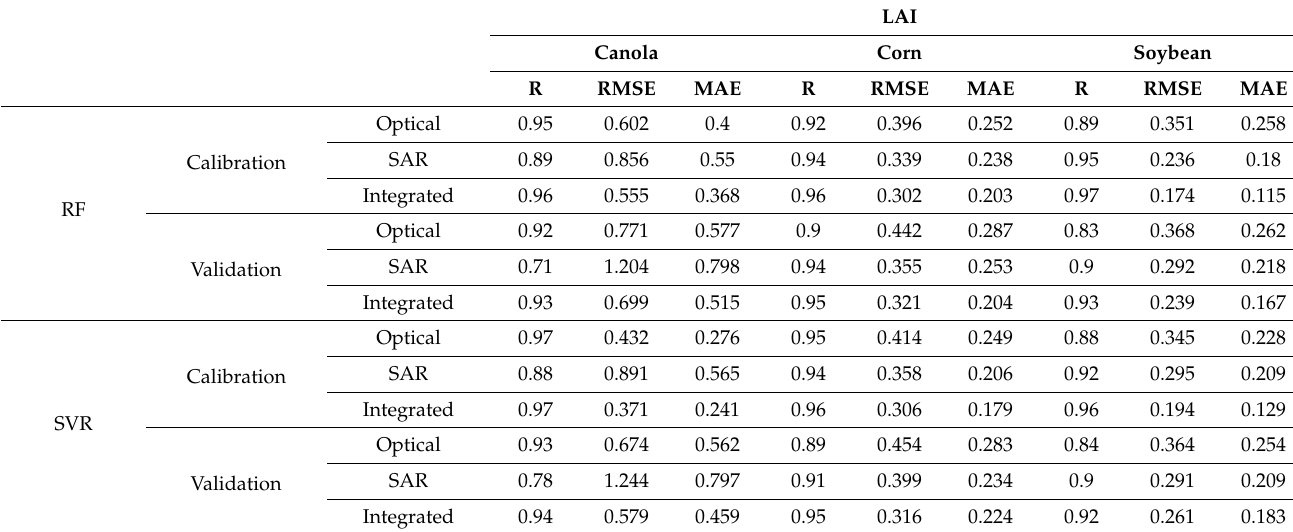
Table 9. Results of four MLAs in estimating